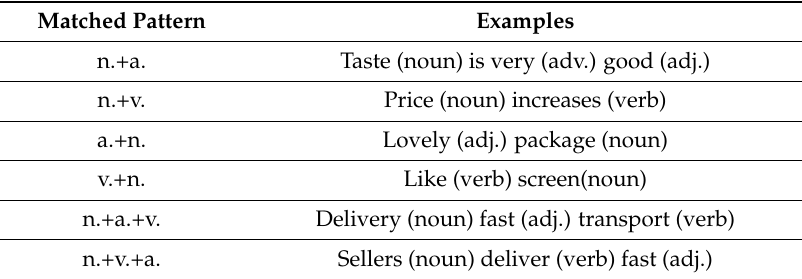
Table 2. Simplified matching